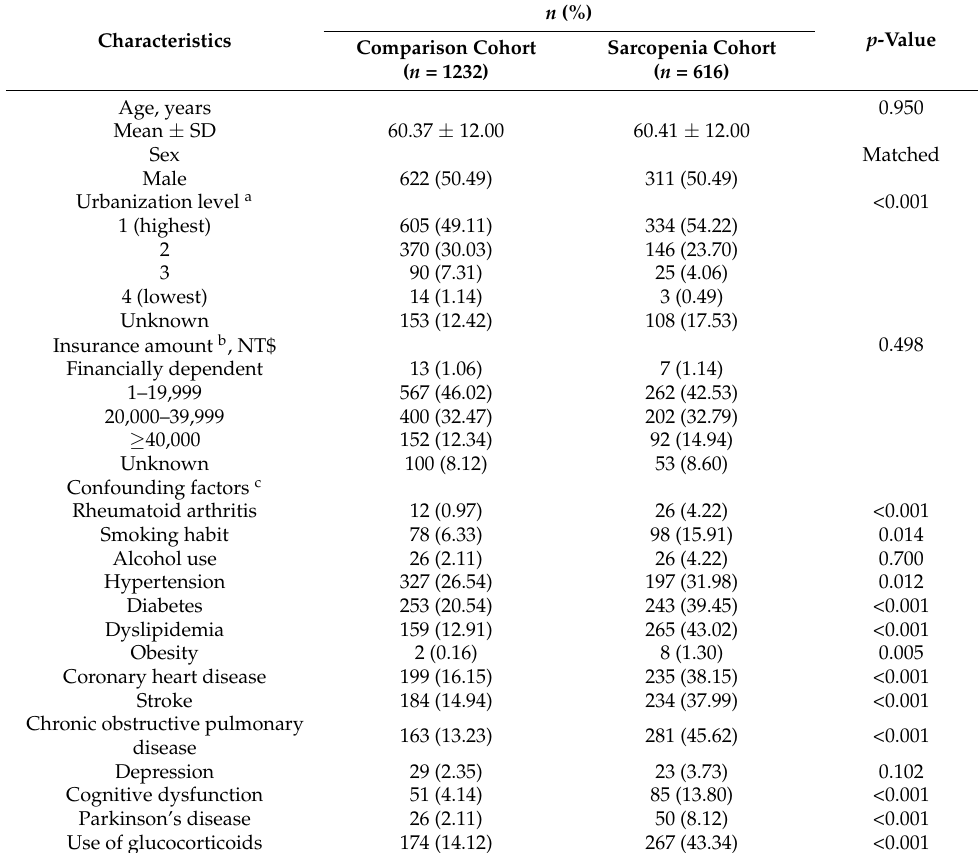
Table 1. Clinical details of the sarcopenia and comparison